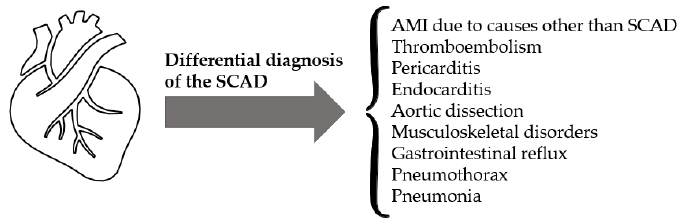
Figure 1. Differential diagnosis of Spontaneous Coronary Artery Dissection.